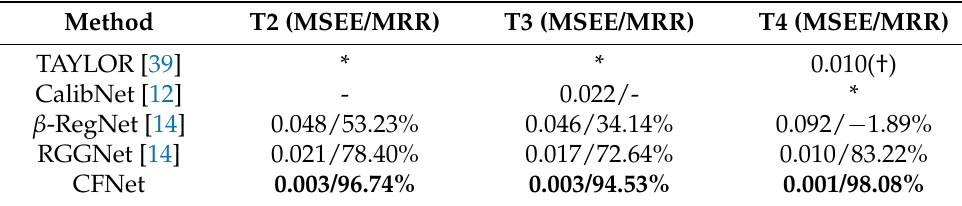
Table 4. The comparison results using the T2, T3, and T4 test datasets.